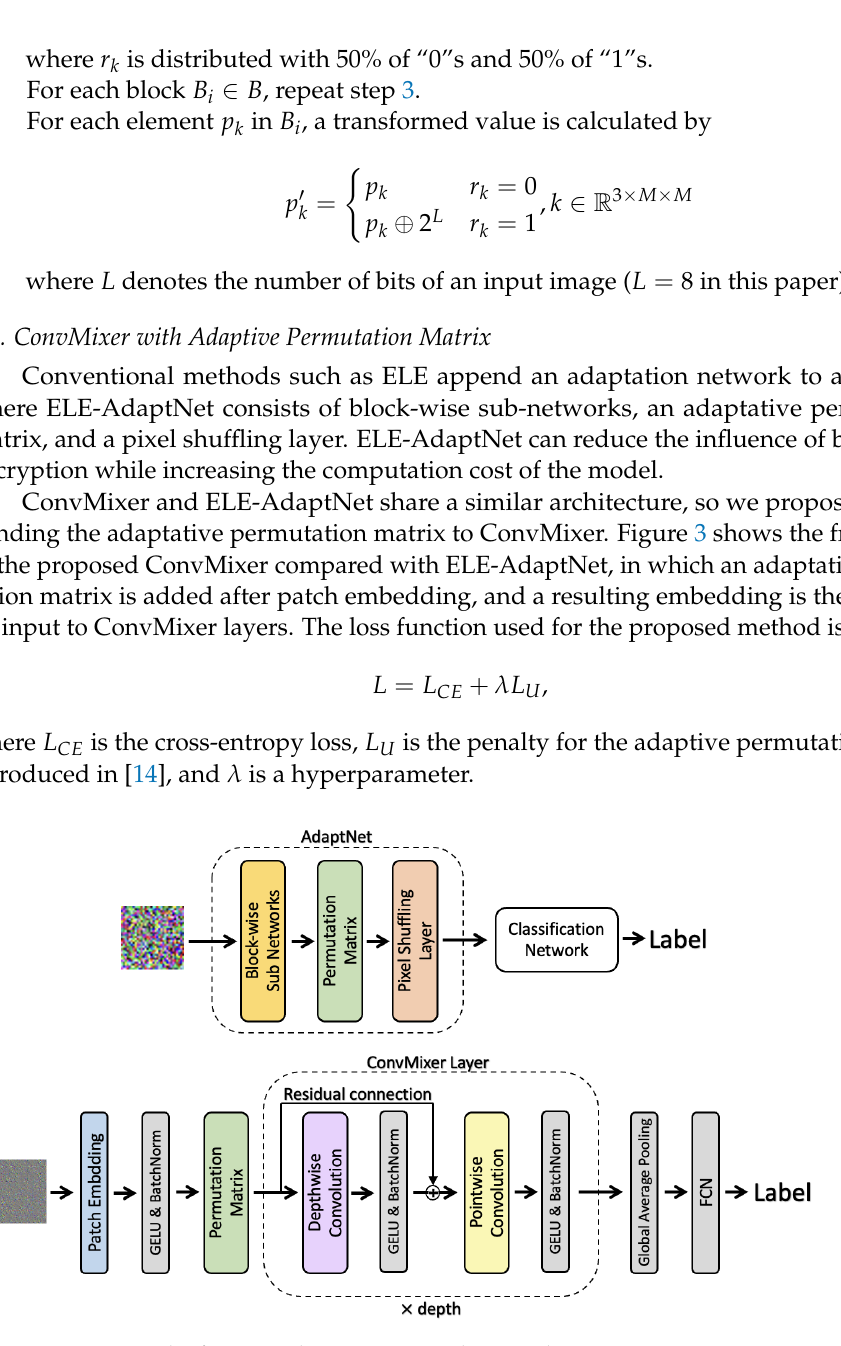
Figure 3. Framework of proposed ConvMixer and